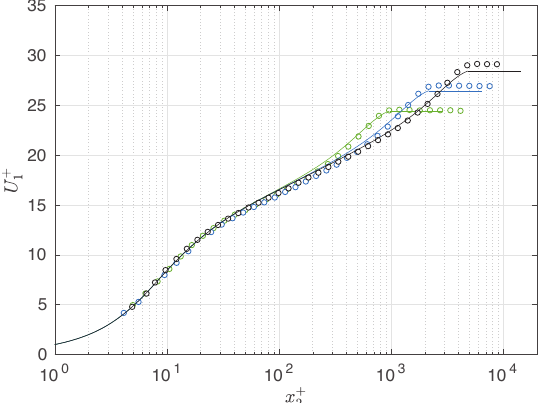
Figure 2. Pro fi les of (cid:1) s þ t given by equation (8) for b P ranging from (cid:2) 10 to 0 (blue) and by equation (7) for b P = 0 (black).